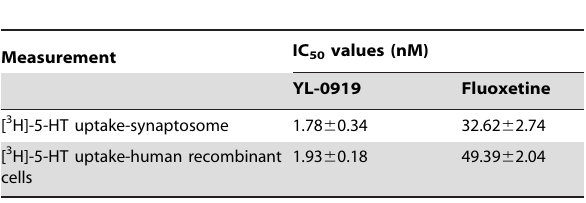
Table 4. The functional properties of YL-0919 and fluoxetine on